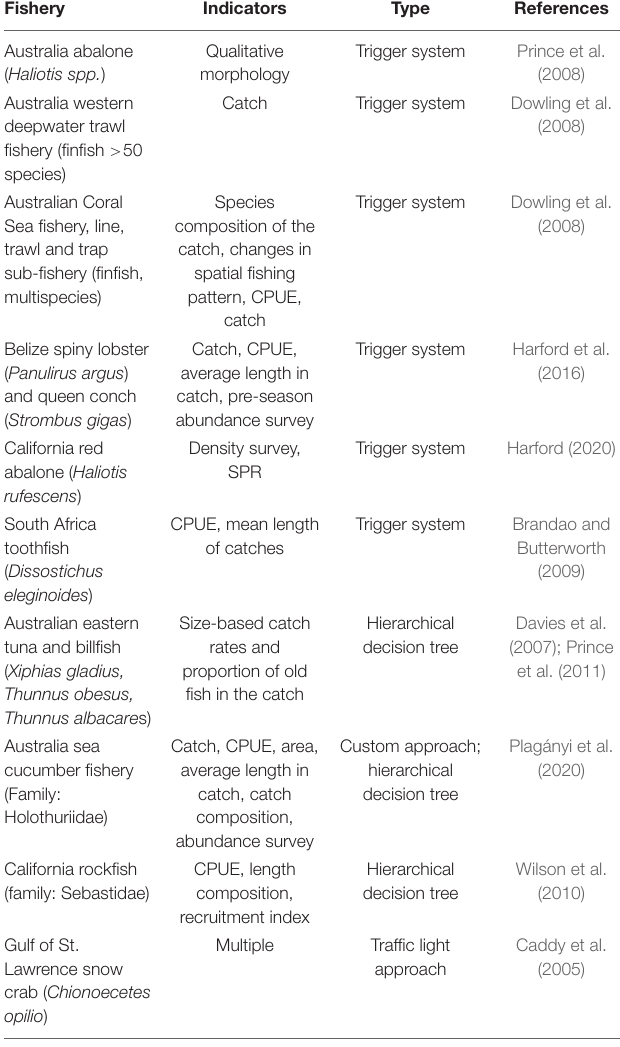
TABLE 1 | Examples of multi-indicator